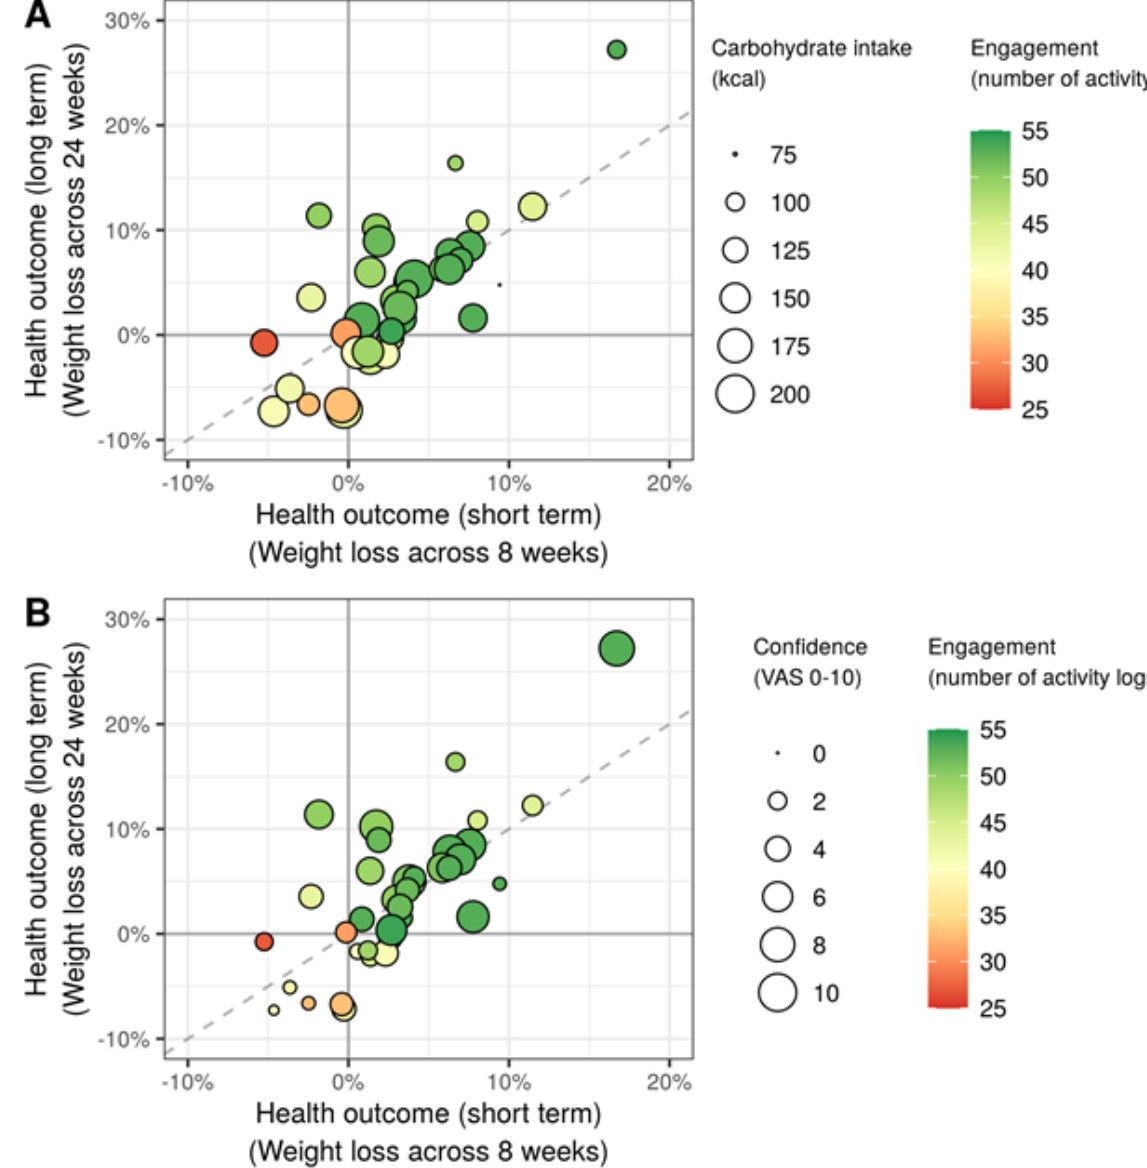
Figure 5. Two examples of common predictors between short-term and long-term health outcomes: (A) carbohydrate intake and (B) confidence in digital phenotypes. VAS: Visual Analogue